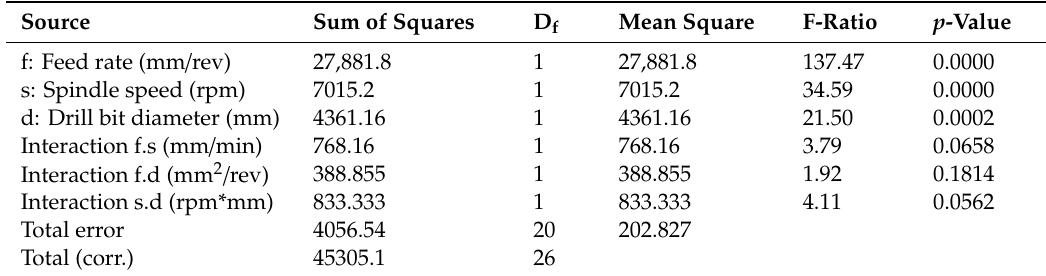
Figure 7. Specific cutting energy for thrust force as a function of spindle speed with different feed rates and drill bit diameter of 10 mm. 3.3. Surface Roughness The surface roughness is one of the criteria for determining the machined surface quality. In the present research work, the surface roughness parameters were measured in the hole in a longitudinal direction. The roughness parameters were measured three times for each hole, with a cut-off length of 0.8 mm. The mean arithmetic average roughness (R a ) value and the maximum profile height (R t ) obtained from the measured results were used for evaluating the effect of cutting conditions on the machined surface. Figure 8 presents the measured profile of holes drilled in the longitudinal direction, at different cutting conditions. Figure 8a shows the drilled hole with the best surface finish at cutting condition (f = 0.2 mm/rev, s = 600 rpm, d = 6 mm). The highest surface roughness value was obtained at cutting condition (f = 0.3 mm/rev, s = 2400 rpm, d = 10 mm), illustrated in Figure 8b. The morphology of the surface before machining and the machined surface with the largest surface roughness value is presented in Figure 9. The machined surface indicates that neither uncut fibers nor delamination were found.